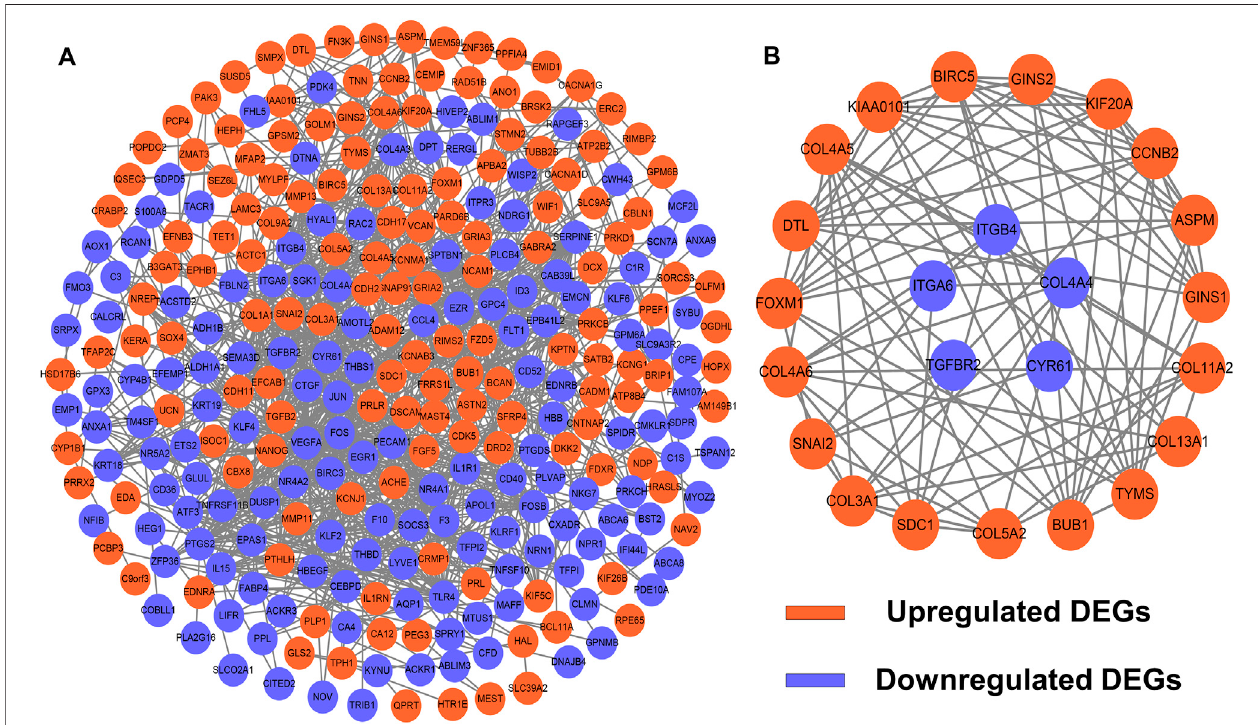
FIGURE 3 | PPI network and module analysis. (A) 373 DEGs were visualized in the PPI network. (B) Module analysis using MCODE.